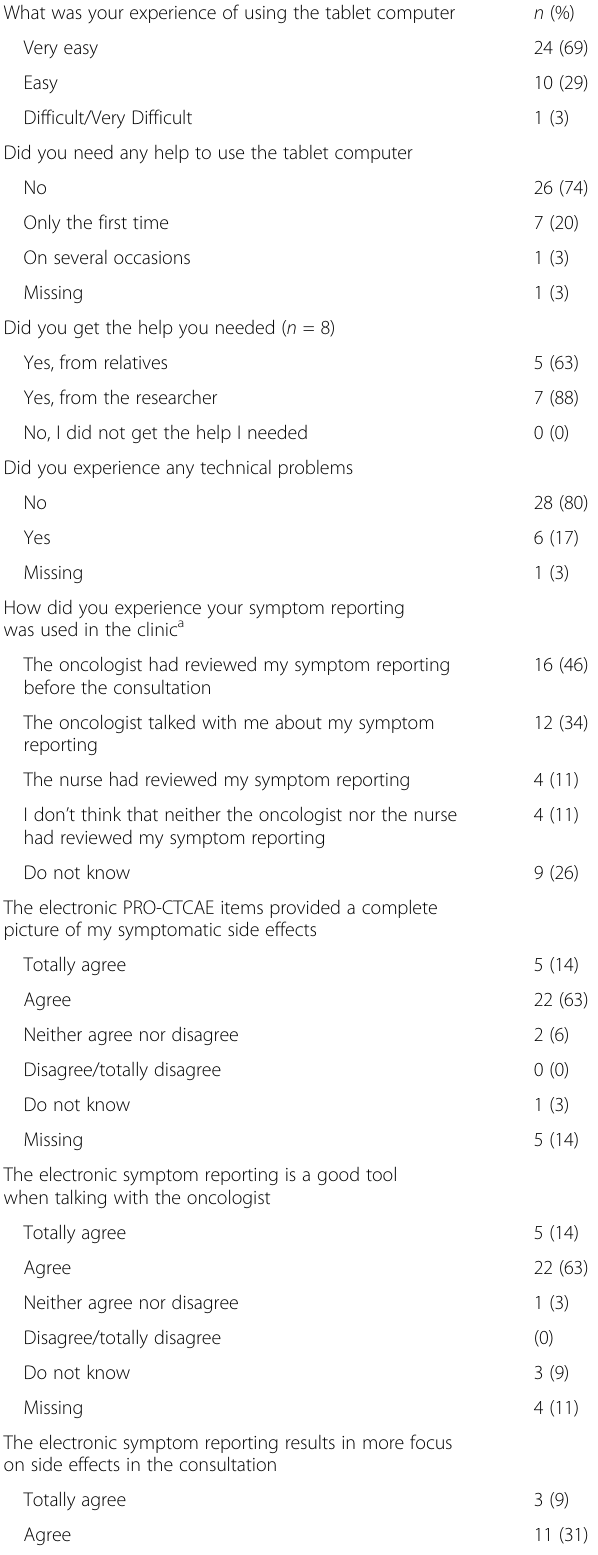
Table 4 Results from the patient evaluation questionnaire